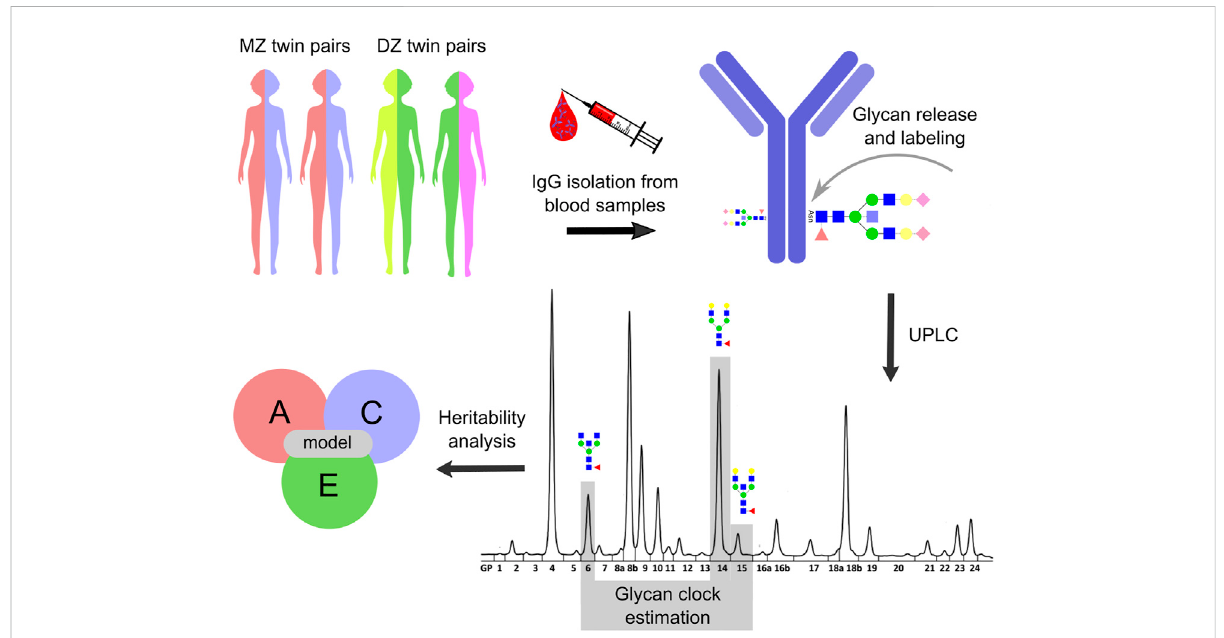
FIGURE 1 Studydesign.HeritabilityanalysiswasperformedontheglycanclockdatafromtheTwinsUKregistry.Thestudyincluded479monozygotic(MZ) and 1,193 dizygotic (DZ) female twin pairs. Blood samples were taken from twin pairs involved in one cross-sectional and one longitudinal cohort with three time points. IgG was isolated from collected blood samples which was followed by N-glycan release and labeling. IgG N-glycome composition was analyzed for the cross-sectional cohort by ultra-high-performance liquid chromatography (UHPLC) and the resulting IgG N-glycan chromatograms were separated into 24 distinct peaks. The glycan clock was estimated from GP6, GP14 and GP15 peaks as described in Kri š ti ć et al., 2014. Utilizing ACE model the heritability of the glycan clock was calculated. From this model, the contribution of genetic (A), shared environmental (C) and unique environmental (E) factors on the phenotypic variation of the glycan clock was estimated. Note that the IgG N-glycan analysis was slightly different for the longitudinal cohort (described in Materials and methods) but was not included for the simplicity of the